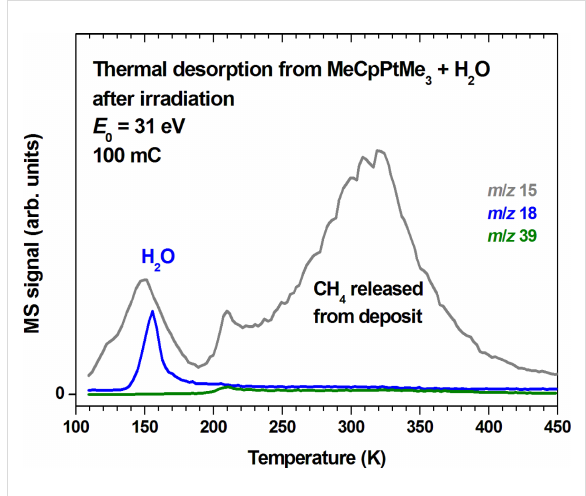
Figure 7: Thermal desorption spectra obtained after an electron expo- sure of 100 mC at E 0 = 31 eV from a 15 layer film of MeCpPtMe 3 condensed on a Ta substrate held at 105 K and covered by a three- fold excess of H 2 O. The ratios m / z 18 and m / z 15 were recorded to monitor desorption of remaining H 2 O as well as possible formation of CH 4 . The m / z ratio 39 (C 3 H 3+ ) is included as a characteristic signal of MeCpPtMe 3 and of MeCpH that may possibly be released from the decomposed layer.